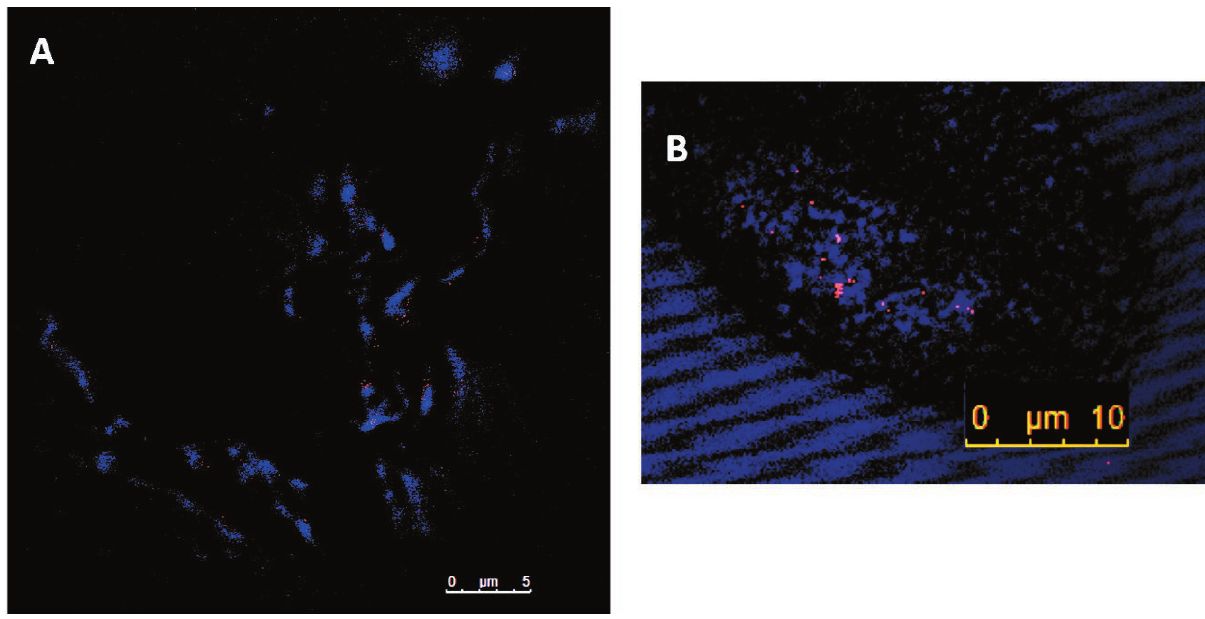
Figure 2. Display of Sukkula LTRs distributions in barley root preparations via